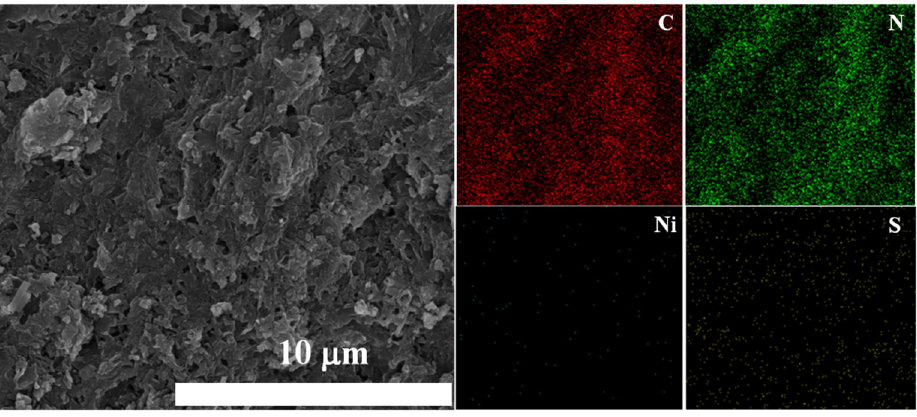
Figure 3. SEM and element mapping images of 1.0 wt% Ni x S y -C 3 N 5